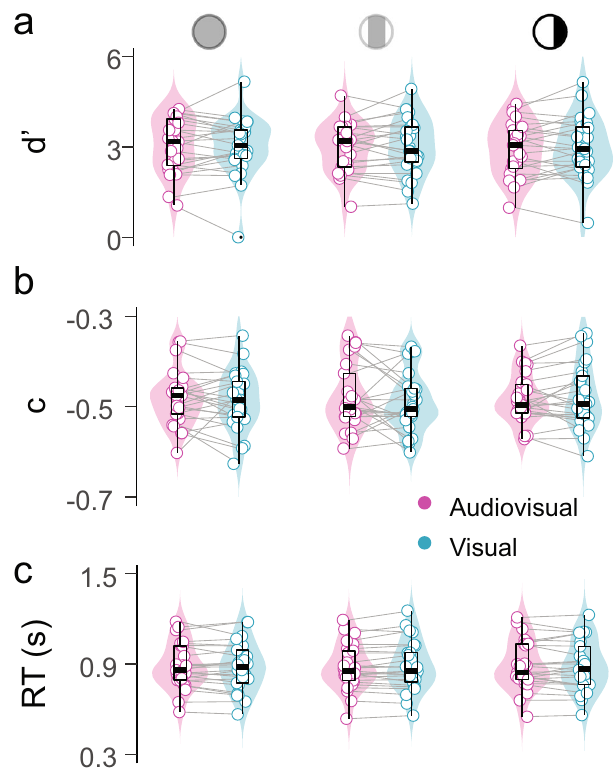
Fig. 7 Behavioral performance in a working-memory task is not affected by the audiovisual distractors. Behavioral results in the working-memory task: Sensitivity ( a ), criterion ( b ) and reaction times ( c ) are represented for each modality (audiovisual/visual), distractor contrast (S − /S + /S ++ ) and participant. Inside the violin plot, the horizontal black line re fl ects the median, the thick box indicates quartiles, and whiskers 2 times the interquartile range. Gray horizontal lines connect participants scores across